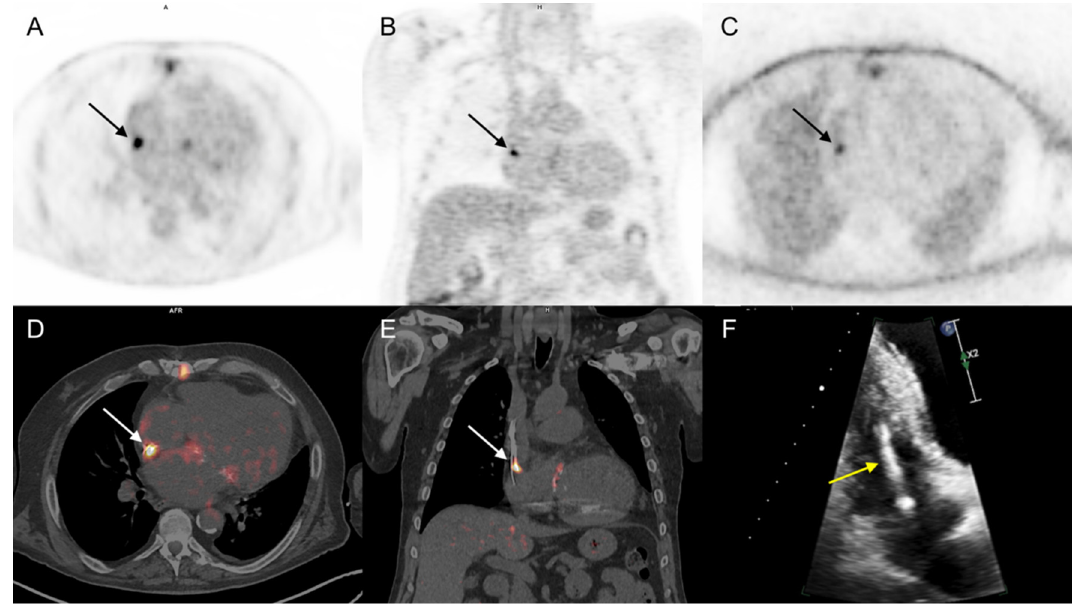
Figure 3. 68-year-old man with a history of implantable cardioverter defibrillator (ICD) and a biological prosthetic mitral valve presented with 10-mm enlargement of ICD lead within the right auricle at TTE (yellow arrow) but normal routine biological evaluation and negative blood cultures (Duke 1/high clinical suspicion degree). PET/CT showed increased focal 18 F-FDG uptake, corresponding to right auricle ICD lead (arrows). The Endocarditis Team’s final diagnosis was CIED IE, and ICD was removed. ( A , B ): PET, attenuation-corrected axial, and coronal slices. ( C ): PET, non-attenuation corrected axial slice. ( D , E ): PET/CT, axial, and coronal attenuation corrected slices. ( F ): TEE.